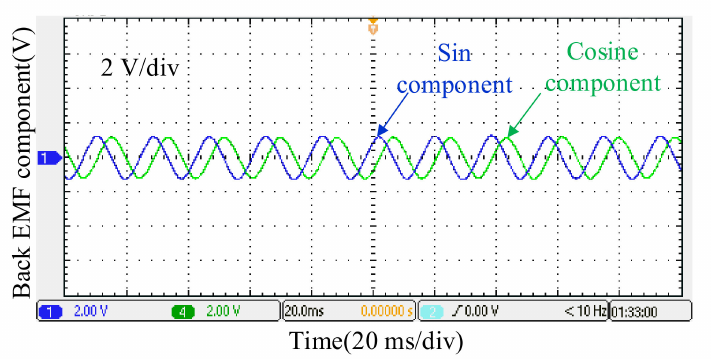
Figure 16. Extended back-EMF component when the motor operates at 800 rpm.